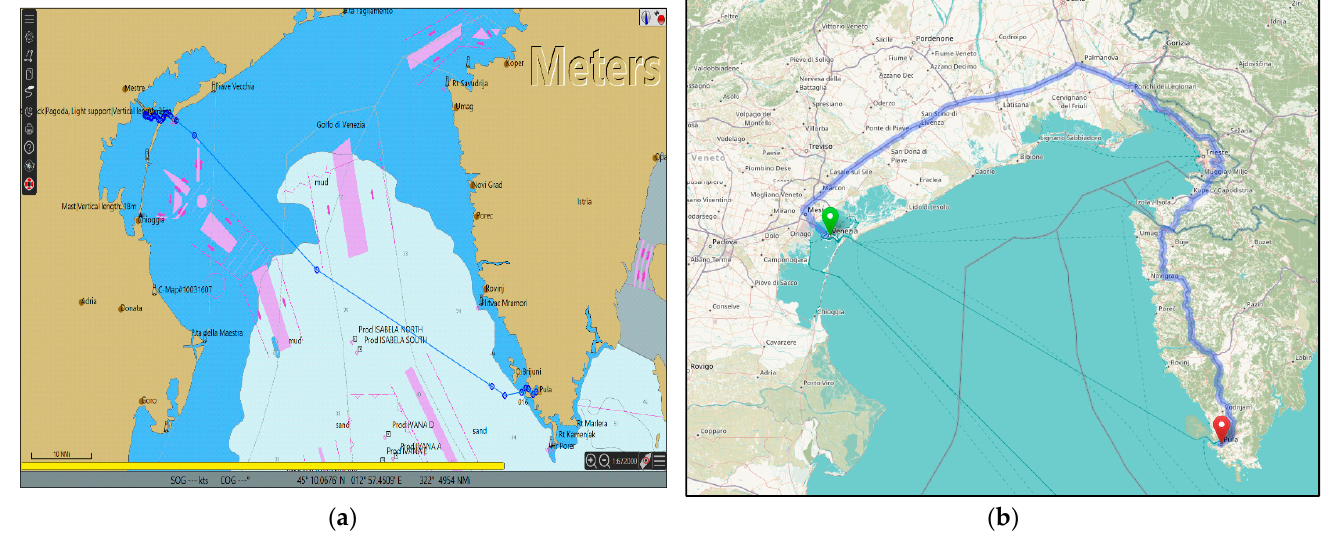
Figure 3. Route segment 𝑅 (cid:2869) 𝑆 (cid:2869) : ( a ) maritime transportation; ( b ) road transportation. Table 6. Distances traveled in the specific navigation mode on the route segment 𝑅 (cid:2869) 𝑆 (cid:2869)